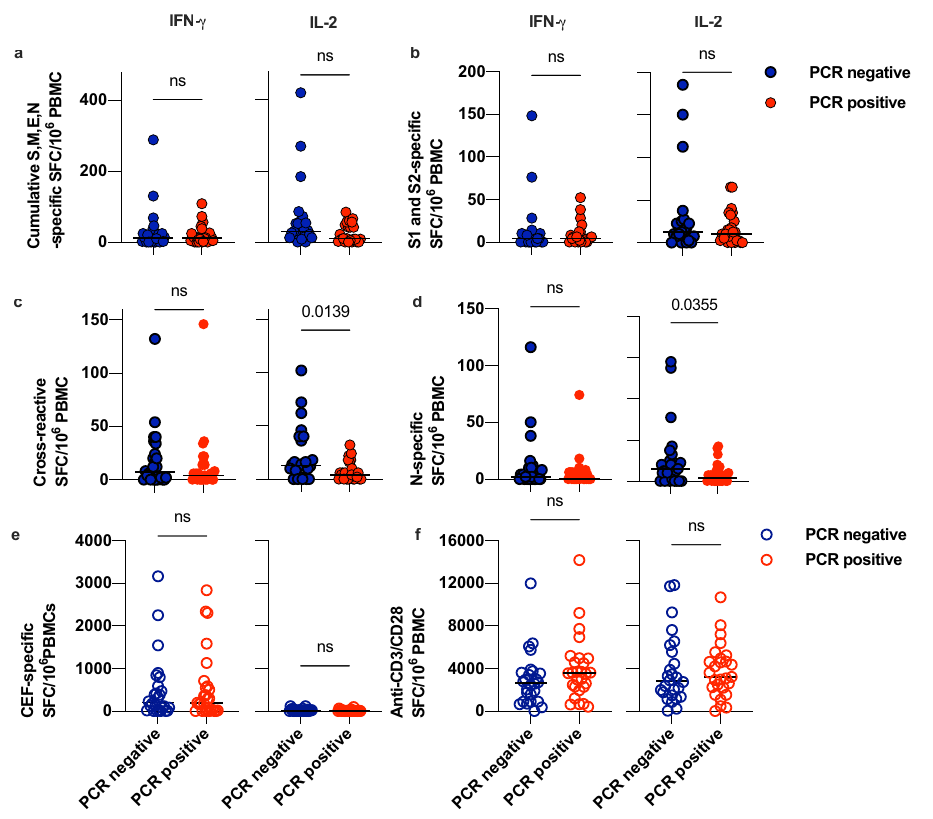
Fig. 2 Dual cytokine FLISpot responses to SARS-CoV protein-spanning peptide pools and the cross-reactive pool in PCR-positive and PCR-negative COVID-19 contacts. PBMCs sampled from COVID-19 contacts ( n = 52) at the baseline visit were rested overnight at high density prior to stimulation with 1 µ g/ml/peptide pools, 1 µ g/ml CMV-EBV-Flu (CEF) positive control peptide pool or 1 µ g/ml anti-CD3 and 1 µ g/ml anti-CD28 antibody as indicated and cultured for 20 h in a FLISpot assay to detect IL-2- (left-hand panels) and IFN γ (right-hand panels) secreting T cells. Data are DMSO-subtracted spot forming cells per 1 × 10 6 PBMC. Blue circles represent PCR-negative contacts and red circles represent PCR-positive contacts. Filled circles represent test data from SARS-CoV-2 stimuli and the outline circles represent values from positive control stimuli. a Depicts cumulative frequency of pan-S,M,E and N-speci fi c T cells using protein-spanning 15-mer peptide pools to represent the entire protein, rather than predicted epitopes, as a stimuli. b Depicts the frequency of pan-S-speci fi c T cells, using protein-spanning 15-mer peptide pools to represent the entire protein, rather than predicted epitopes, as stimuli. c Depicts the frequency of cross-reactive T cells, using peptides derived from the putative MHC-I and MHC-II epitopes de fi ned in our bioinformatic analysis and Nelde et al, as listed in Supplementary Table 1. d Depicts the frequency of pan-N-speci fi c T cells using protein-spanning 15-mer peptide pools to represent the entire protein, rather than predicted epitopes, as a stimuli. e Depicts the frequency of T cells speci fi c to an antigen-speci fi c positive control peptide pool comprising of well-characterised epitopes from in fl uenza, cytomegalovirus and Epstein – Barr Virus. f Depicts the frequency of IL-2 and IFN γ secreting T cells activated in response to a polyclonal stimulus of anti-CD3 and anti-CD28 soluble antibody. Data are from n = 26 PCR-positive and n = 26 PCR-negative contacts and p -values are from a two-sided Welch ’ s T